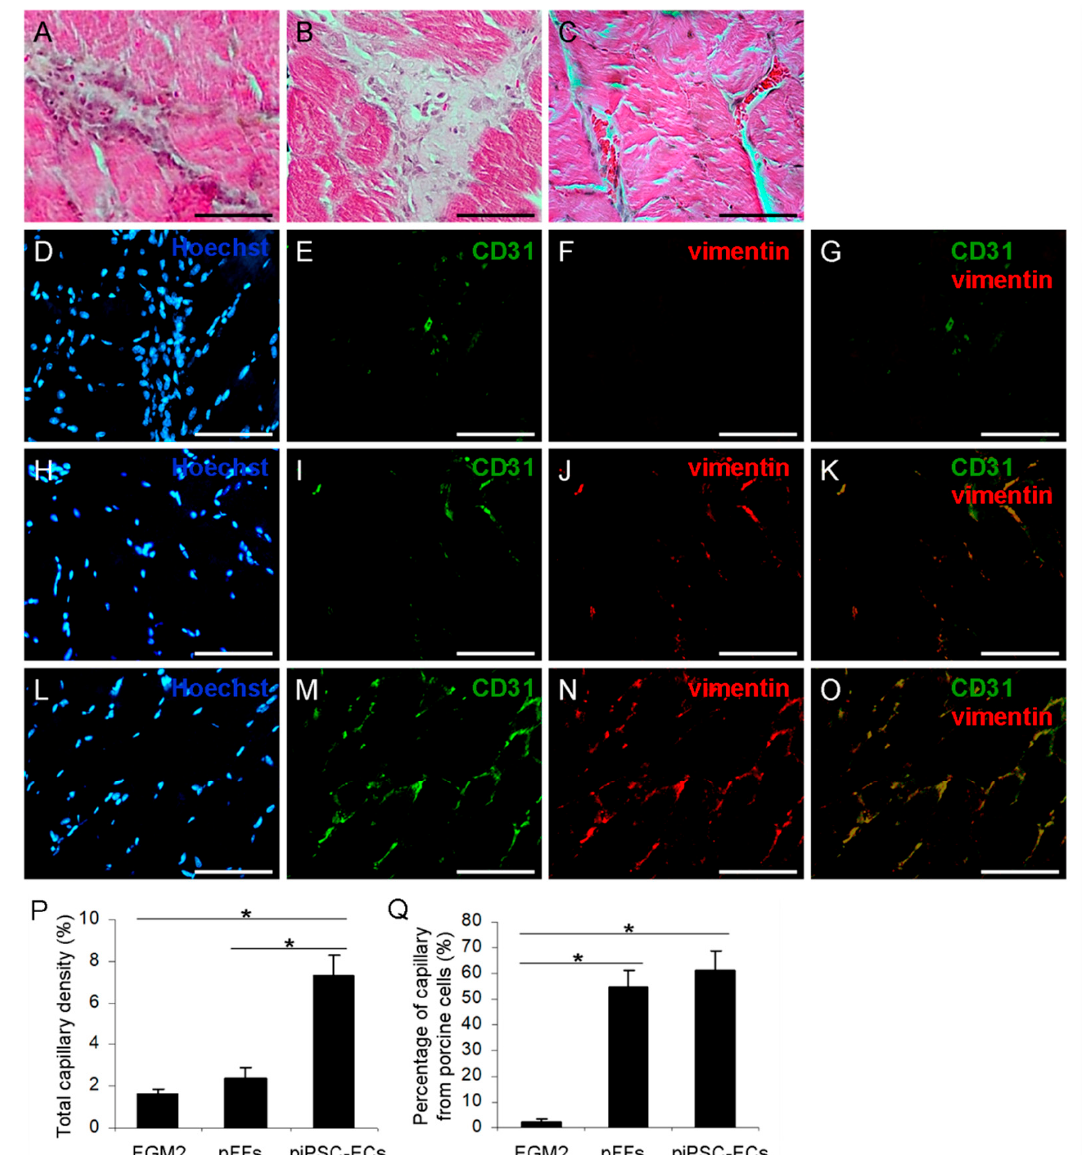
Figure 3. Histomorphology and angiogenesis of adductors after cell transplantation. ( A – C ) Histomorphological observation of mice treated with EGM ‐ 2 ( A ), PFFs ( B ) and porcine iPS ‐ ECs ( C ). Scale bar = 100 μ m. ( D – O ) Angiogenesis of mice treated with EGM ‐ 2 ( D – G ), PFFs ( H – K ) and porcine iPSC ‐ ECs ( L – O ). Blue fluorescence represents the nuclei labeled by Hoechst33342 ( D , H , L ). Green fluorescence represents CD31 expression ( E , I , M ). Red fluorescence represents porcine ‐ specific vimentin expression ( F , J , N ). Merged images of (E) and (F), (I) and (J) and (M) and (N) ( G , K , O ). Scale bar = 100 μ m. ( P , Q ) Quantitative analysis of angiogenesis in different groups. Total capillary density ( P ). Percentage of capillary from porcine cells ( Q ). Mean ± SD, n = 6. The bars labeled with an asterisk are significantly different ( p < 0.05).